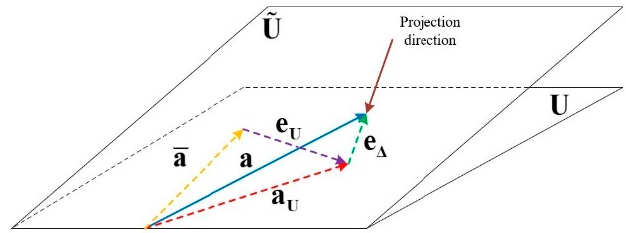
Figure 2. Geometrical depiction on the relationship among the subspaces (cid:101) U and U , the error vectors e U and e ∆ , the steering vector a , a U , and a